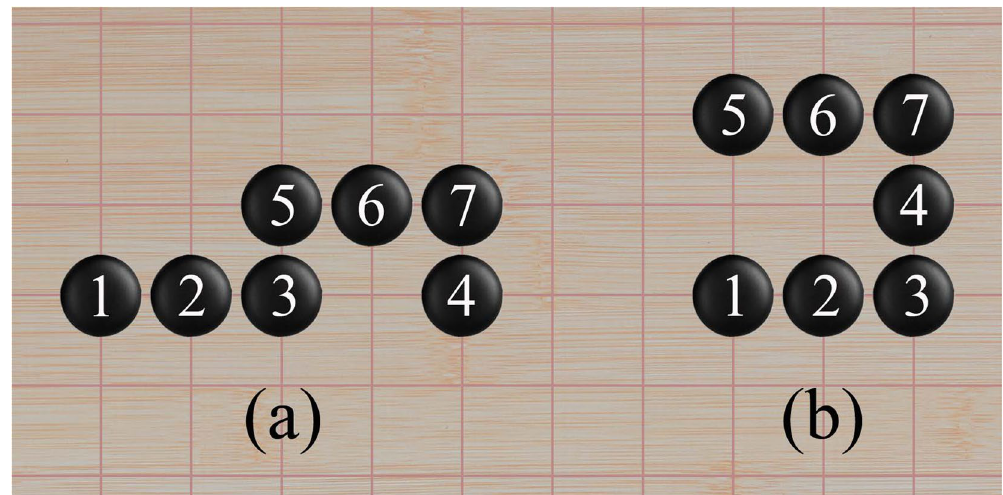
Figure 3. The two configurations for cluster of 7 atoms corresponding to the minimum vertex-type sequence (1,5,8,2,10,5,9) ( a ), and (1,5,8,6,1,5,9) ( b ),